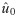
Simulation of the eve 3/7 enhancer in D. melanogaster.(A) Illustration of the eve 3/7 enhancer geometry with bound activators (top) vs. with both activators and full putative Knirps+dCtBP+Rpd3+Sin3 complexes (450 kDa) bound (bottom). (B) Dependence of F∞ on protrusion size Ro and the looping conditions δω′. Negative δω′ corresponds to anti-collinear orientation of (rN − r0) with u^0. Here dmin = Rchain + Ractivator and ε = 3 nm. F∞ was computed from 150 simulated data points corresponding to DNA chains of lengths 3751–3900 bp. Error bars are ±1.96 times the standard error of these points. The area shaded in green depicts the range of possible F∞ values, depending on the chosen looping criteria.